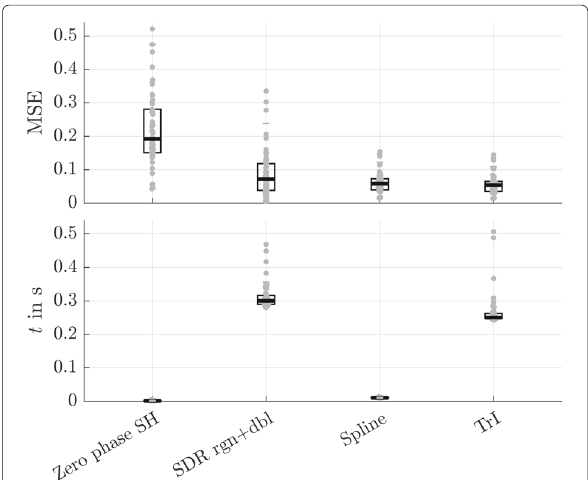
Fig. 7 Distribution of the Mean Square Error MSE (top) and reconstruction time in s (bottom) for interpolation with the (zero phase) SH approach (left), the sign-retrieval algorithm SDR rgn+dbl, the spline method and the triangular technique (right). On each box, the center indicates the median, and the bottom and top edges of the box show the 25th and 75th percentiles,